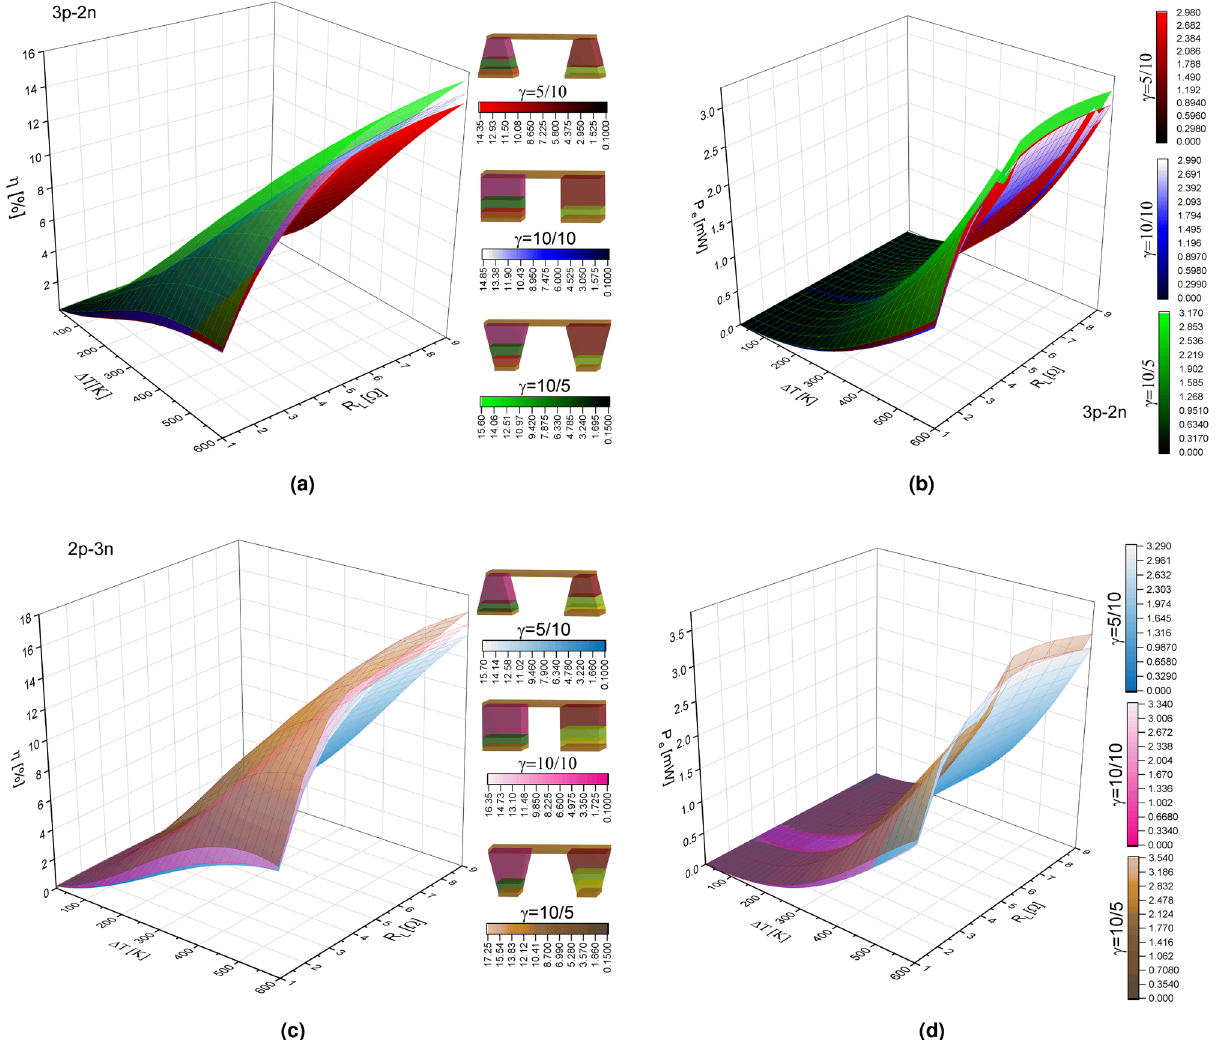
Figure 8. ( a ) Efficiency (η) and ( b ) Output power ( P e ) in function of load resistance ( R L ) and temperature difference (� T ) for a TEG, geometric factor γ = 5 / 10, 10 / 10, 10 / 5 in the 3p-2n model and ( c ) Efficiency (η) and ( d ) Output power ( P e ) for 2p-3n model. Parameter Trapezoidal shape ( γ =0.5) Rectangular shape ( γ =1)